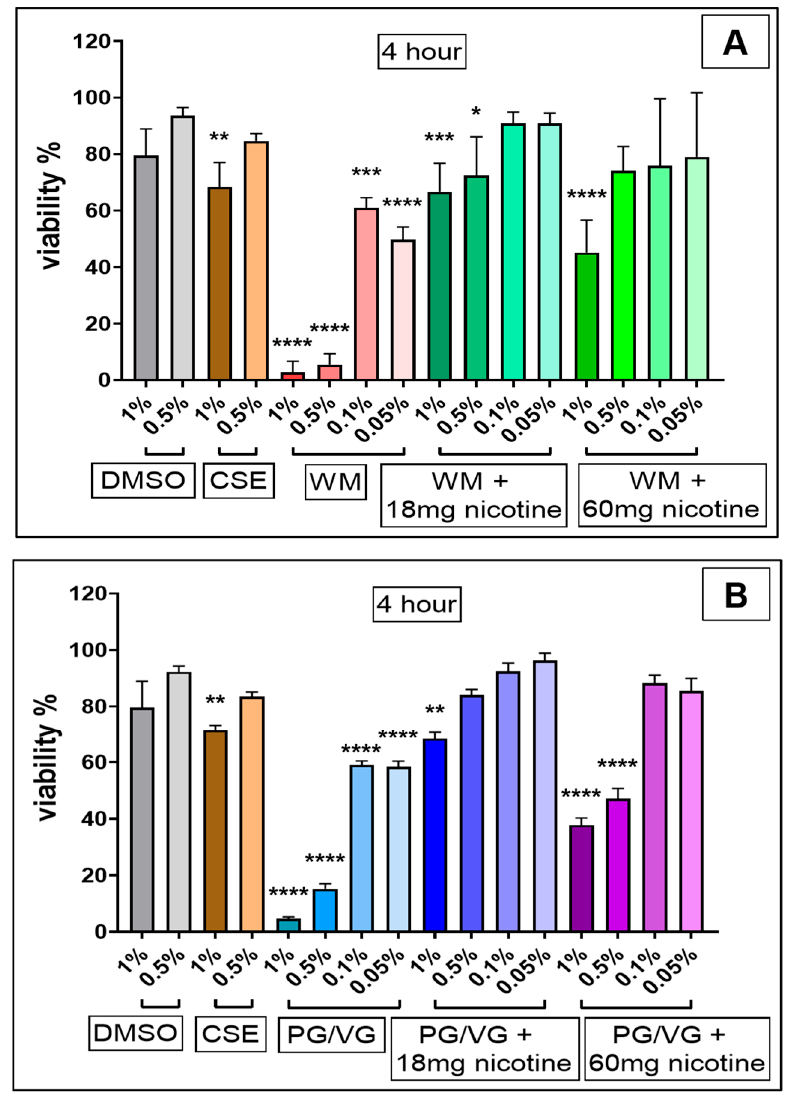
Figure 2. Viability of Bronchial epithelial (BEAS-2B) cells following 4 h electronic cigarette aerosol and cigarette smoke exposure: BEAS-2B cells were exposed to increasing concentrations (0.05%, 0.1%, 0.5% and 1%) of electronic cigarette condensate or cigarette smoke extract (CSE, 1% and 0.5%) for 4 h. Electronic cigarette condensates were generated from ( A ) watermelon (WM)-flavored e-liquid (Juicius Maximus) ± nicotine (18 mg/mL and 60 mg/mL); and ( B ) propylene glycol/vegetable glycerin (PG/VG) ± nicotine (18 mg/mL and 60 mg/mL). Viability was measured in cells treated for 4 h using a cell counting kit-8 (CCK-8) assay and is presented as percent viability in comparison with cell control. Data are displayed as median with interquartile range of n = 3–4 independent experiments. Kruskal–Wallis test with Dunn’s multiple comparison test was performed. * p < 0.05; ** p < 0.01; *** p < 0.001; **** p < 0.0001. DMSO, dimethyl sulfoxide; CSE, cigarette smoke extract.